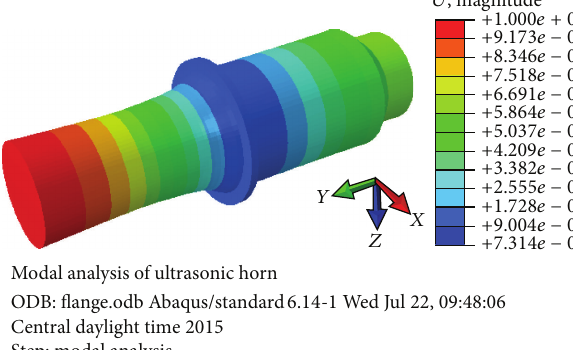
Figure 5: Modal analysis chart of horn with flange.